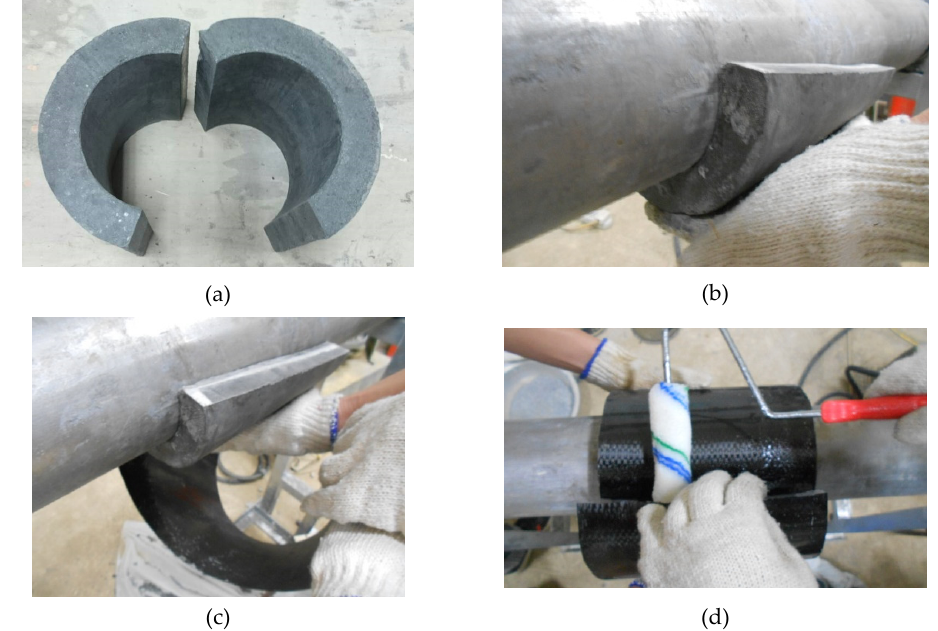
Figure 2. The procedure scheme for rehabilitation method of the high-temperature used pipeline. ( a ) Precast C-shaped insulation material; ( b ) The pipeline was covered by two C-shaped precast